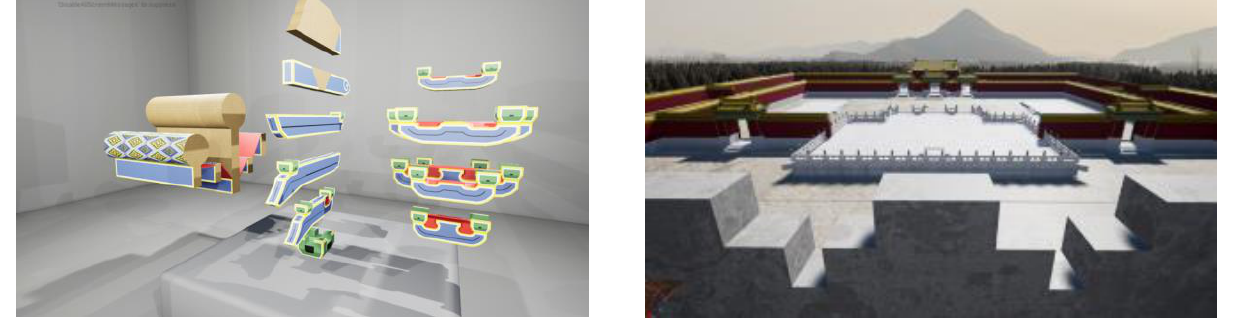
Figure 28. The status quo of Zhaoxi-ling